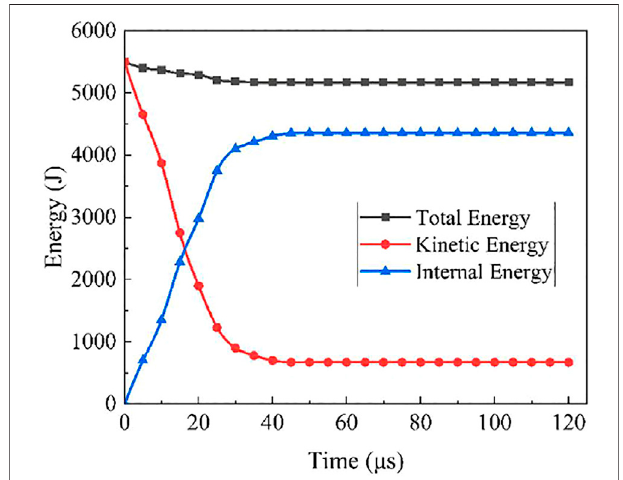
FIGURE 9 | Projectile – target system energy vs